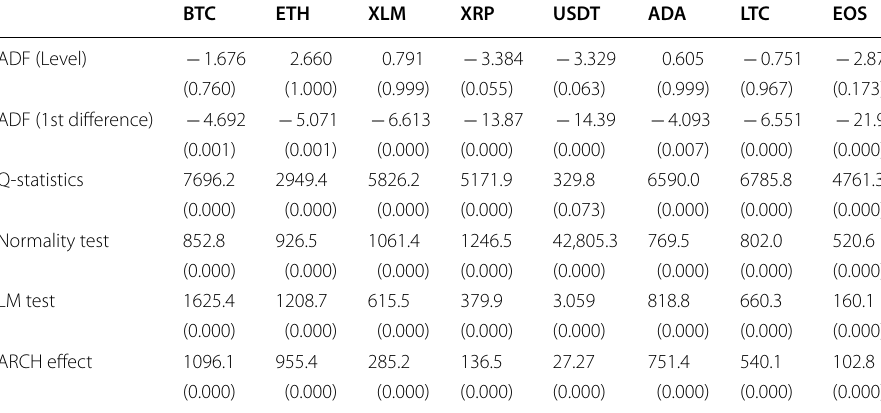
Table 2 Stationary and residual diagnostic tests